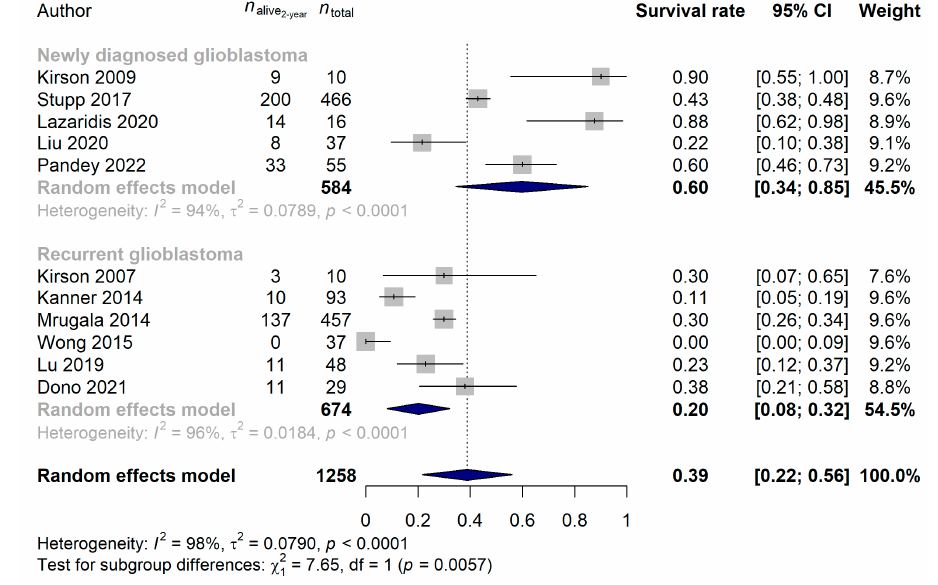
Figure 6. Significantly better 2-year survival rates were found when the Tumor Treating Fields treatment was introduced at an earlier stage of treatment ( p = 0.0057) [15,21,22,26,57,63–65,68–70].